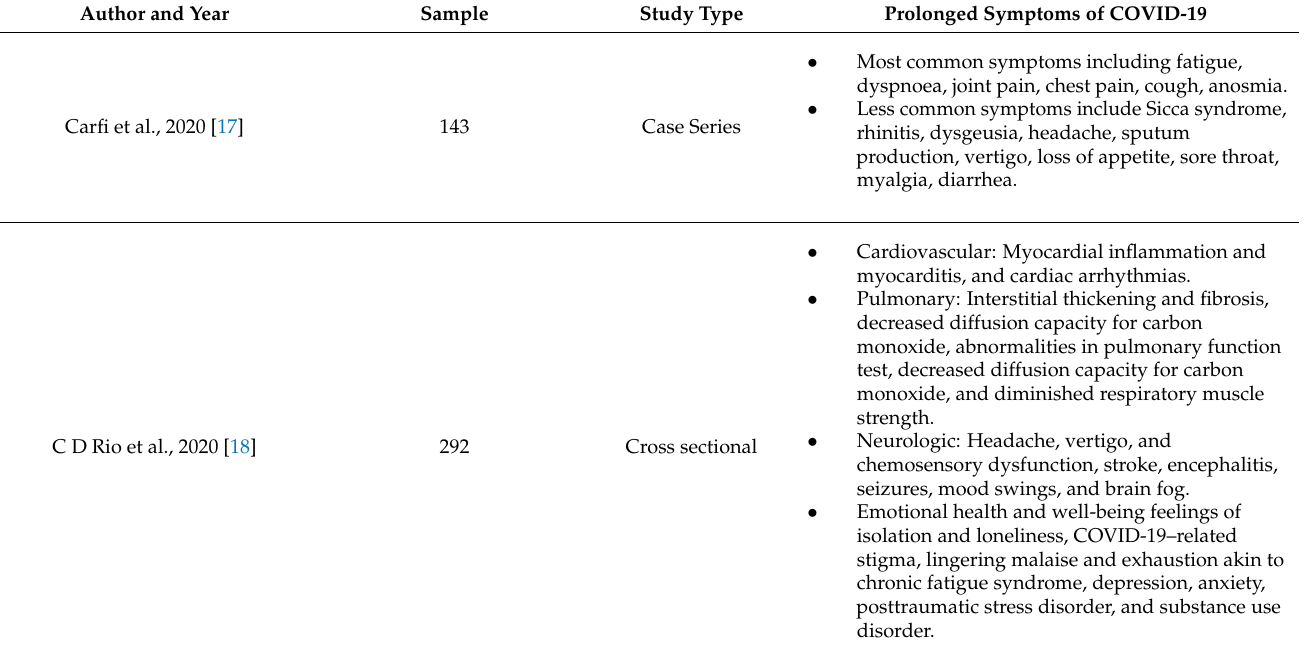
Figure 1. Flow chart of the study selection. Table 1. Summary findings of prolonged post-COVID-19